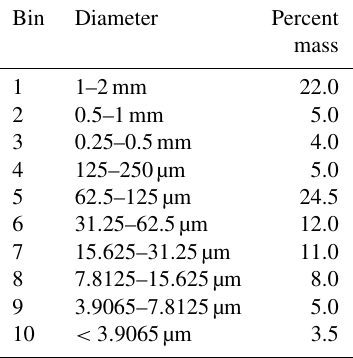
Table 2. Ash aggregation coefficients based on liquid water content, w/w , as described in Van Eaton et al. (2012). The weight percent of water ( w/w ) is calculated as mass of water divided by mass of the atmosphere.